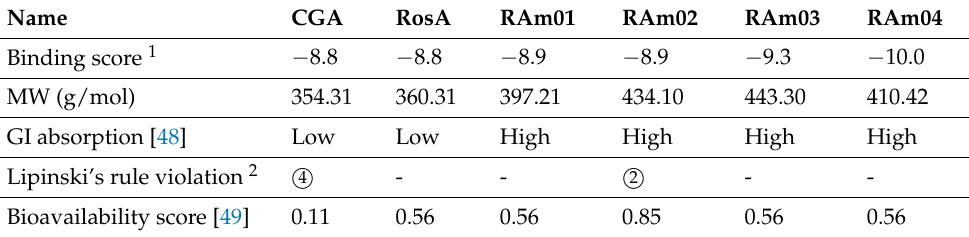
Figure 9. Chemical structures of Cynarin and SalA derivatives. Table 5. RosA Derivative with the prediction of ADME parameters.